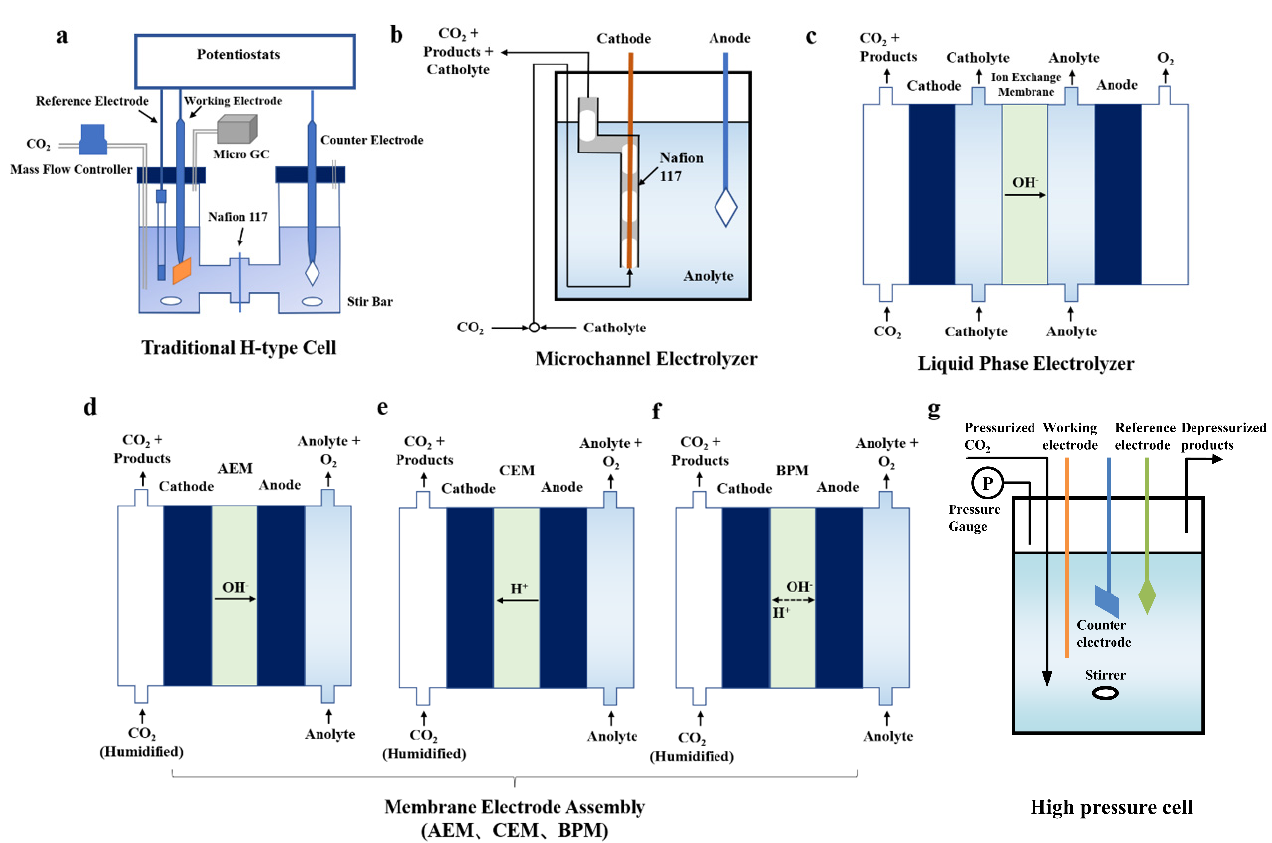
Figure 8. Illustrations of different electrolyzer types. ( a ) H-type cell. Reproduced with permission from Ref. [135]. Copyright 2017 The Royal Society of Chemistry. ( b ) Microchannel electrolyzer. Reproduced with permission from Ref. [136]. Copyright 2020 American Chemical Society. ( c ) Liquid- phase electrolyzer; ( d − f ) membrane electrode assembly (AEM, CEM, BPM) electrolyzers; ( g ) high- pressure cell. Reproduced with permission from Ref. [137]. Copyright 2019 Elsevier Inc.